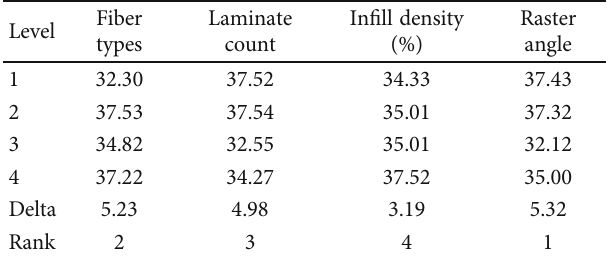
Figure 17: Shore hardness: 3D plot of raster angle and fi ber types. Table 8: Response table for signal to noise ratios (shore hardness).